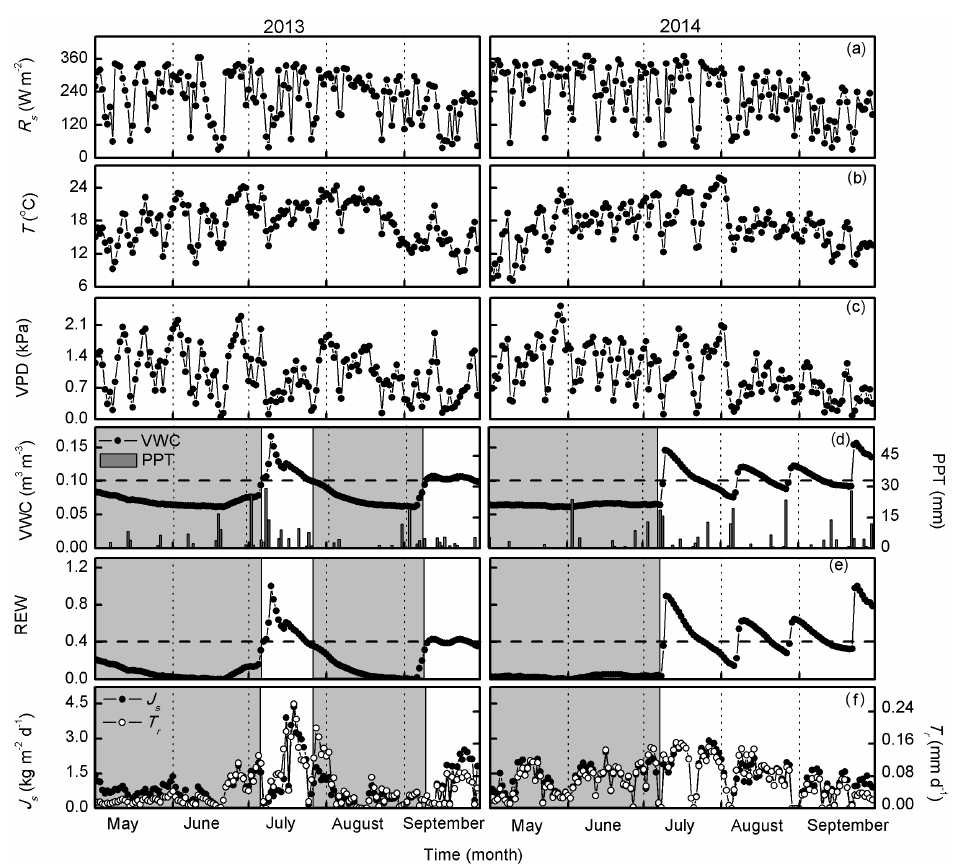
Figure 2. Seasonal changes in daily (24h) mean shortwave radiation ( R s ; a ), air temperature ( T ; b ), water vapor pressure deficit (VPD; c ), volumetric soil water content (VWC; d ), relative extractable water (REW; e ), daily total precipitation (PPT; d ), and daily sap flow per leaf area ( J s ; f ), and daily transpiration ( T r , mmd − 1 ; f ) from May to September for both 2013 and 2014. The horizontal dashed lines in (d, e) represent VWC and REW thresholds of 0.1m 3 m − 3 and 0.4, respectively. Shaded bands indicate periods of